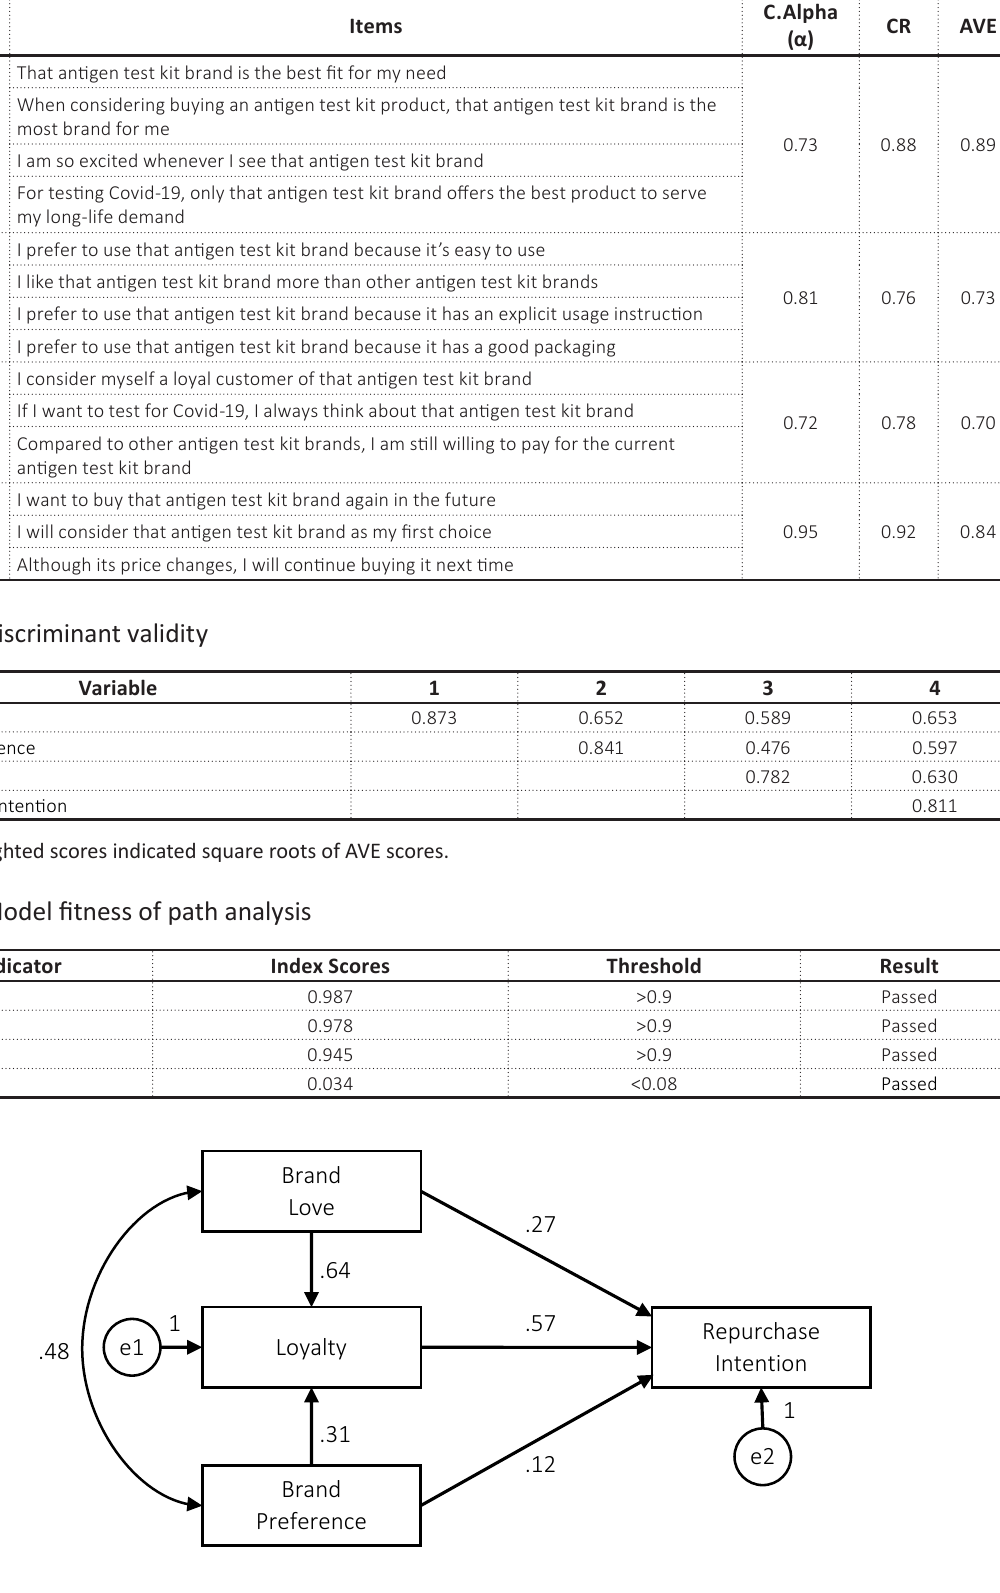
Figure 2. Path analysis